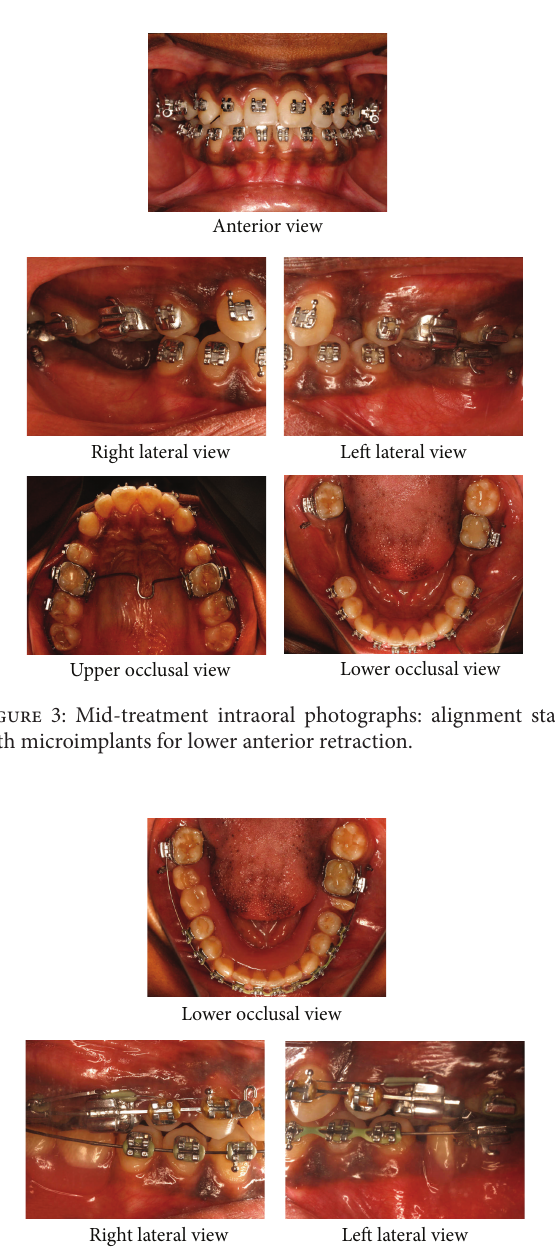
Figure 4: Mid-treatment intraoral photographs: with lower space